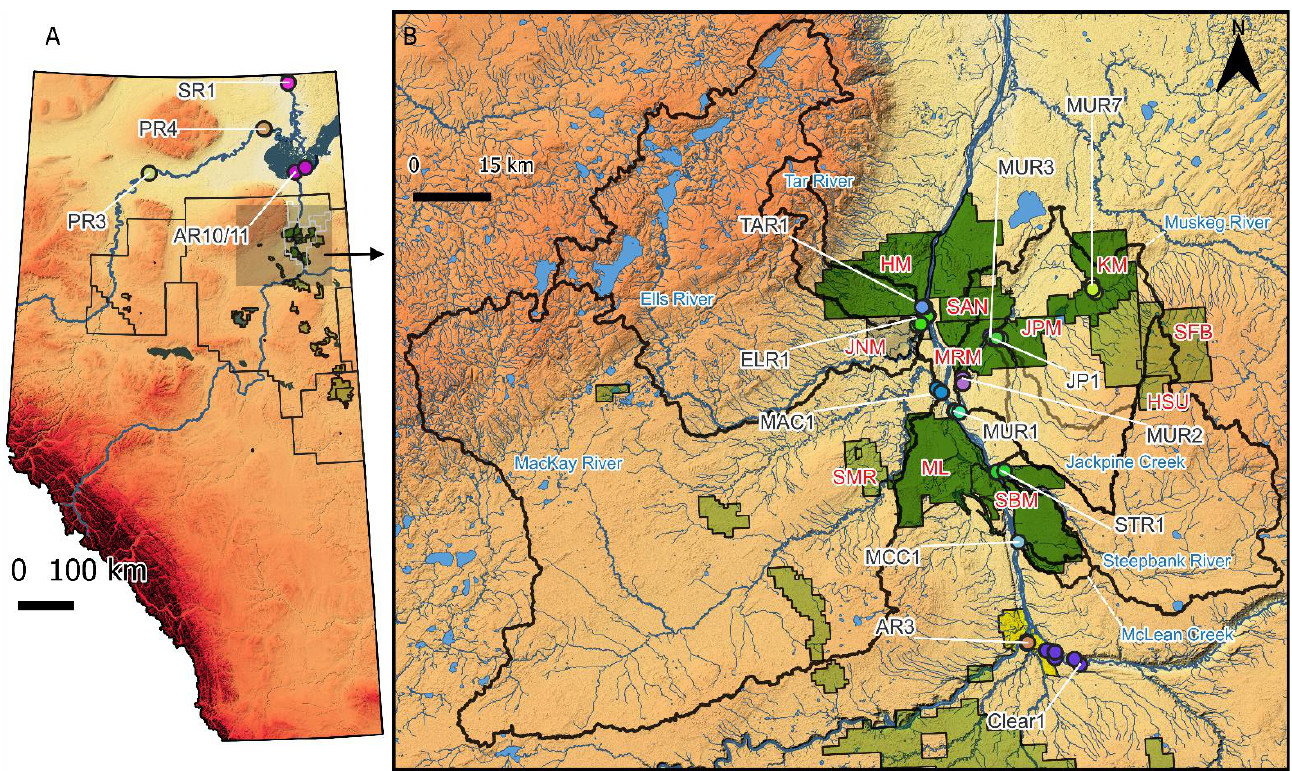
Figure 1. Maps of study area including all 14 locations and industrial project areas (dark green = mines; light green = in situ; grey = paused); ( A ) study locations outside the administrative Oil Sands Areas (black lines) and the minable sub-region (while lines); ( B ) study locations inside and adjacent to the minable region within the Athabasca Oil Sands Region; boundaries of the Tar, Ells, MacKay, Muskeg, and Steepbank rivers, and Jackpine and McLean creeks; original coordinates of all sampling locations were retained and grouped by colors; land disturbance data omitted for clarity; Fort McMurray shown in yellow; only names of relevant projects shown in red text: HM = Horizon mine; SAN = Syncrude Aurora North; KM = Kearl Mine; SFB = Suncor Firebag; HSU = Husky Sunrise; SBM = Suncor Basemine; ML = Mildred Lake; SMR = Suncor MacKay River; MRM = Muskeg River Mine; JNM = Joslyn North Mine; JPM = Jackpine Mine; additional details available in Figure S1.